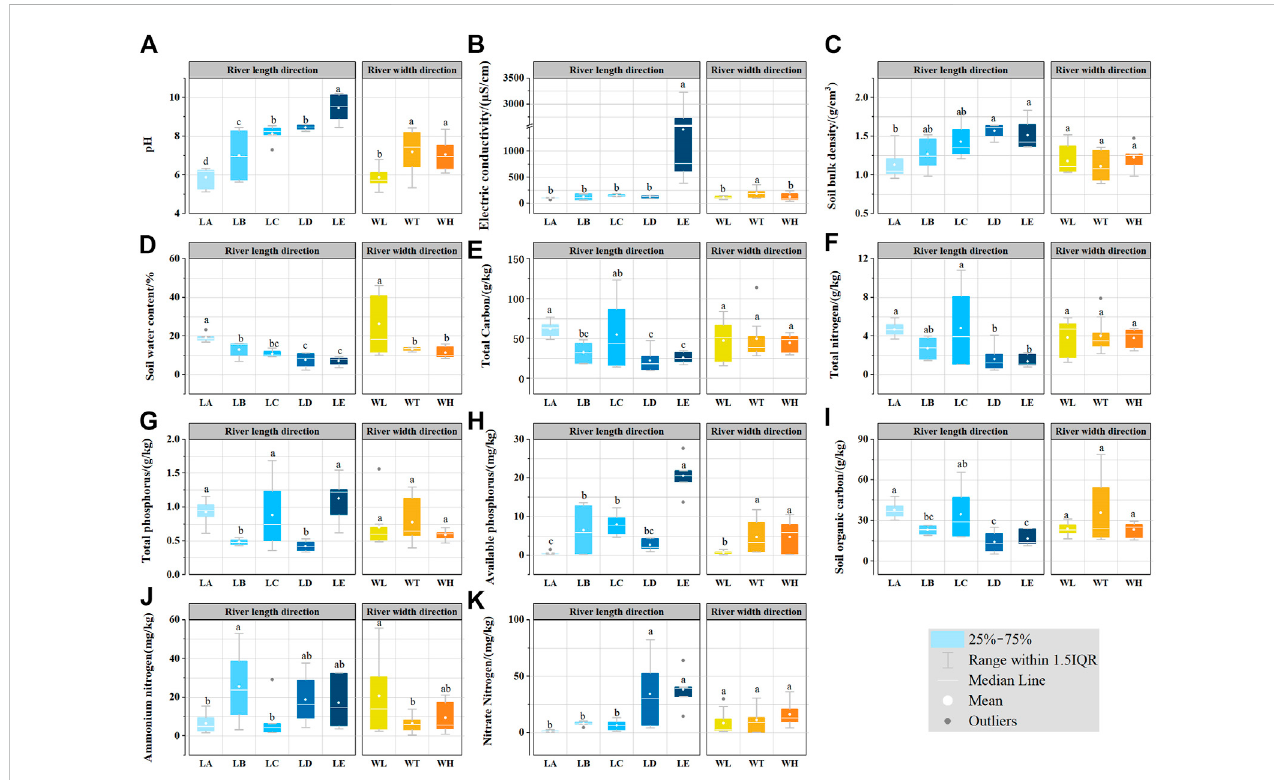
Physicochemical properties of soils in the riparian zone under different gradients: (A) pH; (B) electrical conductivity; (C) soil bulk density; (D) soil water content; (E) total carbon; (F) total nitrogen; (G) total phosphorus; (H) available phosphorus; (I) soil organic carbon; (J) ammonium nitrogen; (K) nitrate